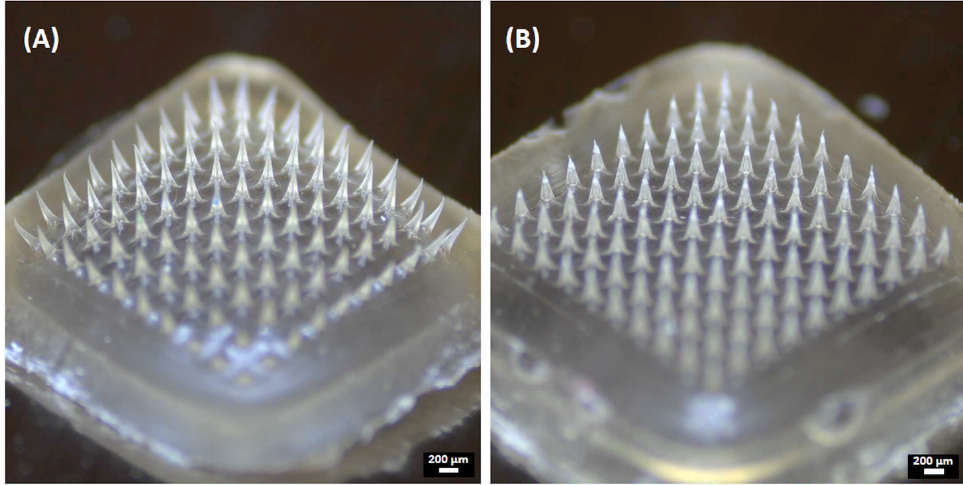
Figure 5. Representative images of the obtained microneedles: ( A ) SA-MNs and ( B ) NP-MNs.